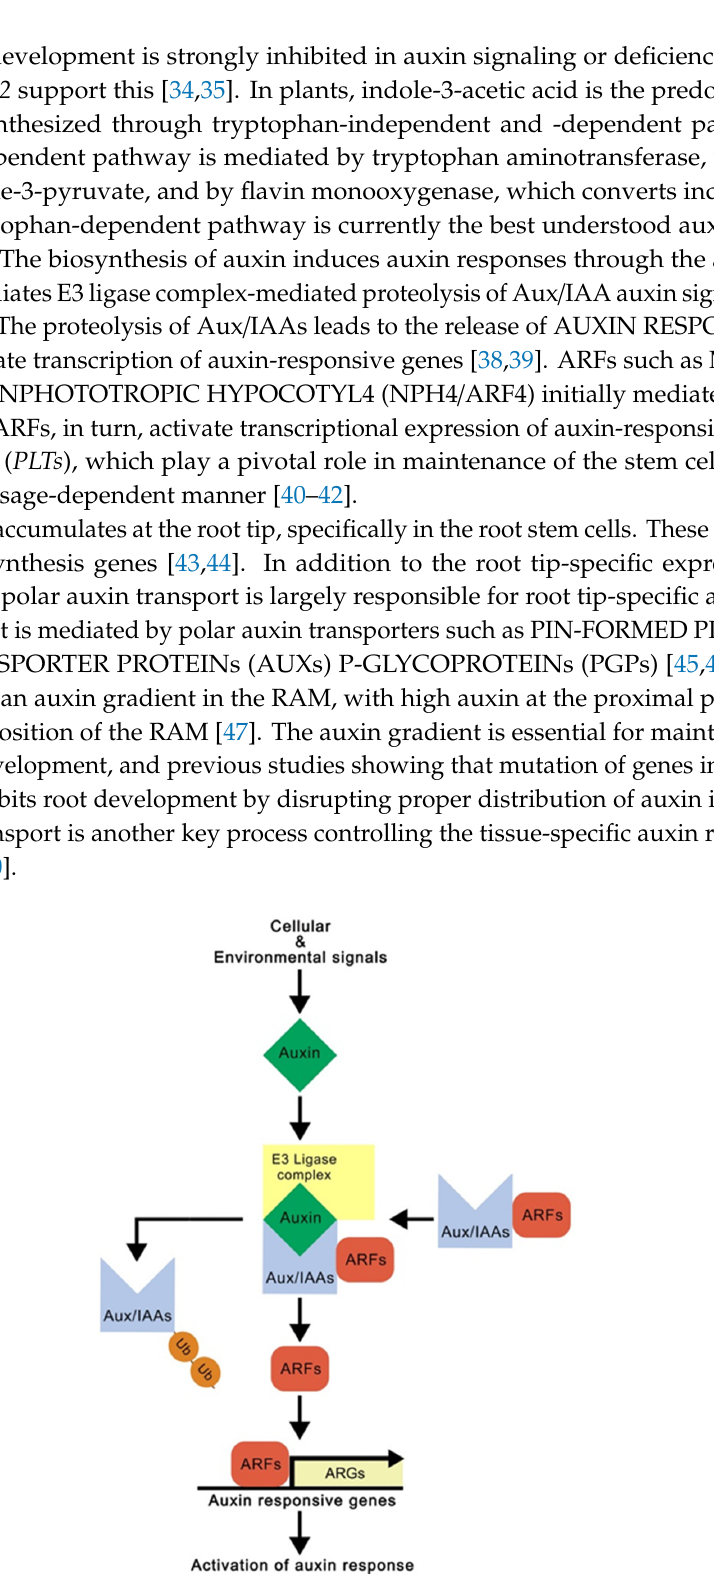
Figure 1. A schematic of the auxin signaling pathway. ARFs and Aux / IAAs function as positive and negative regulators in the auxin signaling pathway. In response to cellular and environmental signals, auxin is biosynthesized and the auxin promotes E3 ligase complex-mediated proteolysis of Aux / IAAs. The degradation leads to the release of ARFs and the activation of auxin response. Ub and ARGs indicate ubiquitin and auxin-responsive genes, respectively.